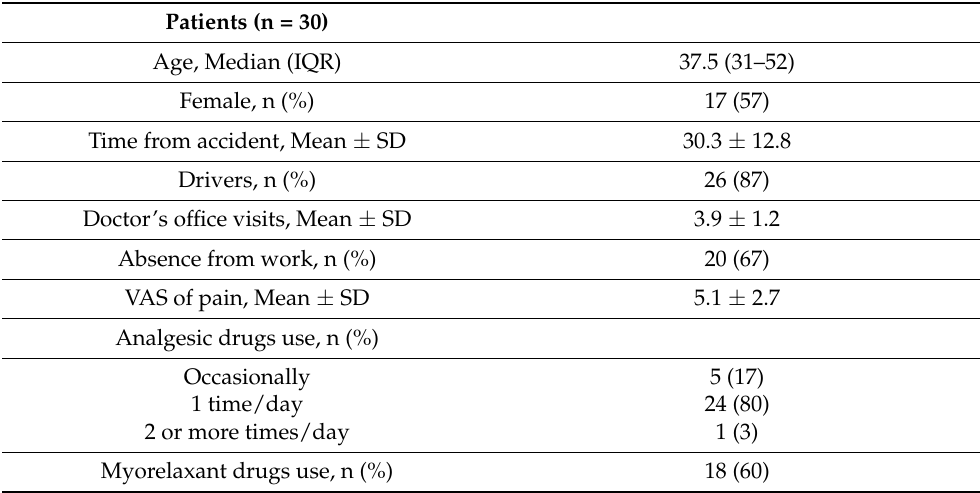
Table 1. Demographic and baseline characteristics of whiplash injury patients that met eligibility